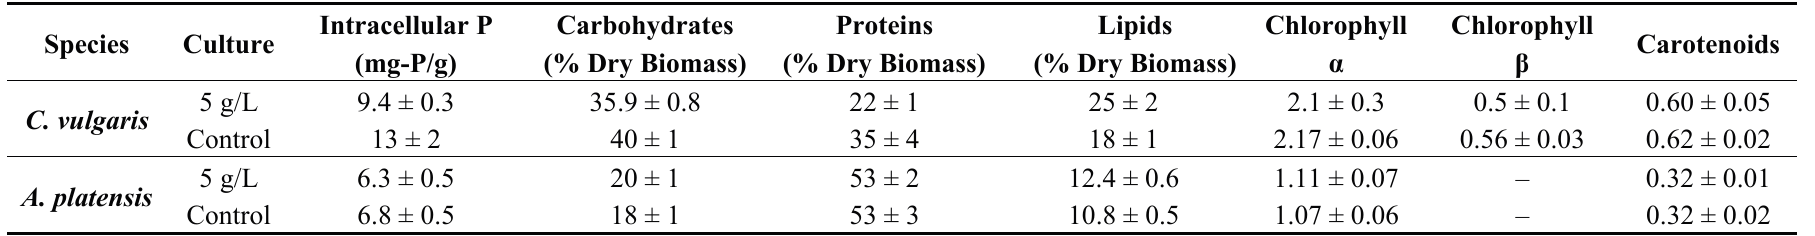
Table 2. Biochemical composition of C. vulgaris and A. platensis cultivated with 5 g/L P-loaded zeolite as P